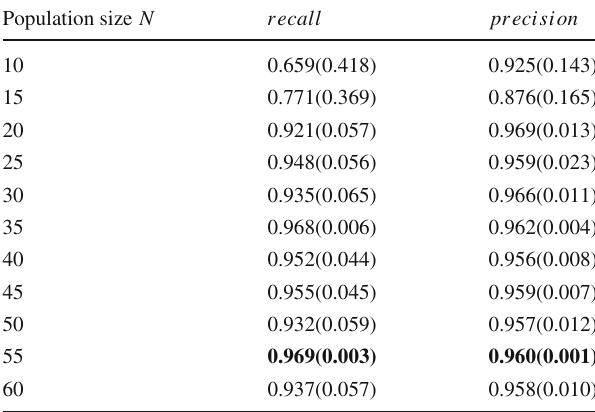
Table 5 Results of sensitivity experiments for population size N Population size N